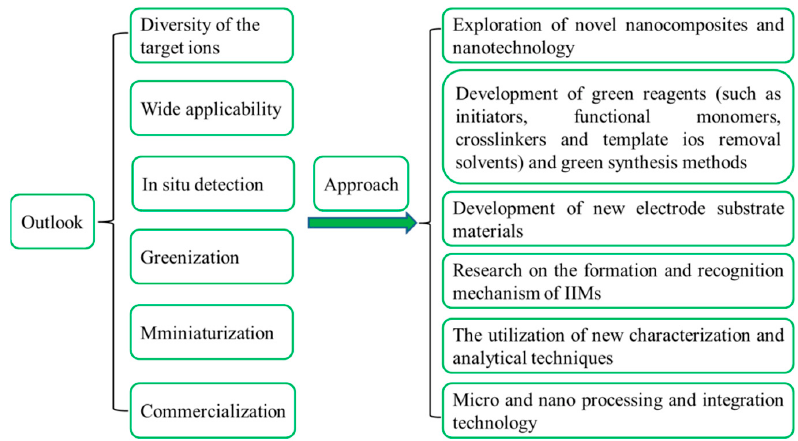
Figure 15. The future outlook and development trends of HMIIECSs.